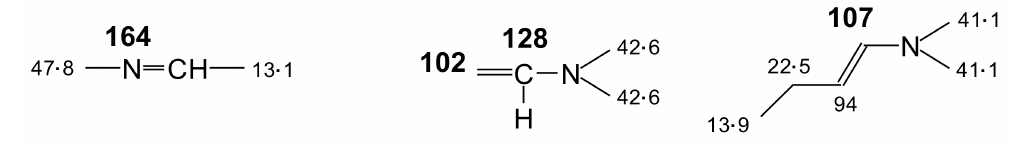
Figure 17. Internal rearrangement of the amine and the amine-DMC adducts corresponding to the 164, 129, 108 ppm